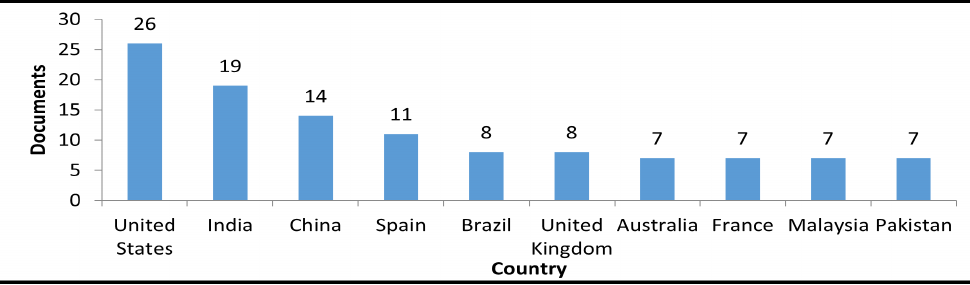
Figure 3. Top ten countries for IoT in plant disease detection research publications.